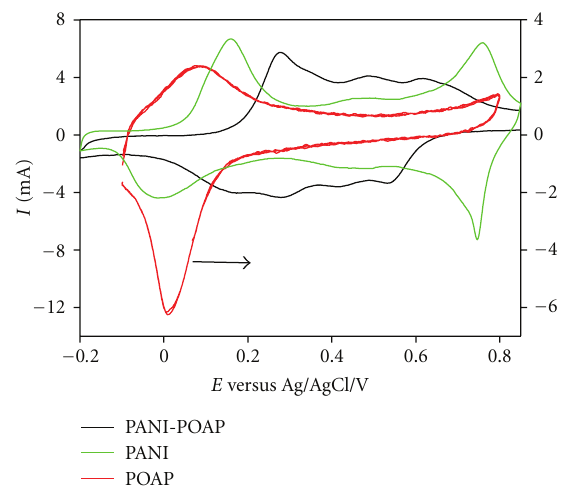
Figure 2: The cyclic voltammograms of the PANI-, POAP-, PANI- POAP-coated Pt electrodes in 0.1 M HCl and 0.4M NaCl solution, at a scan rate of 50mVs − 1 .